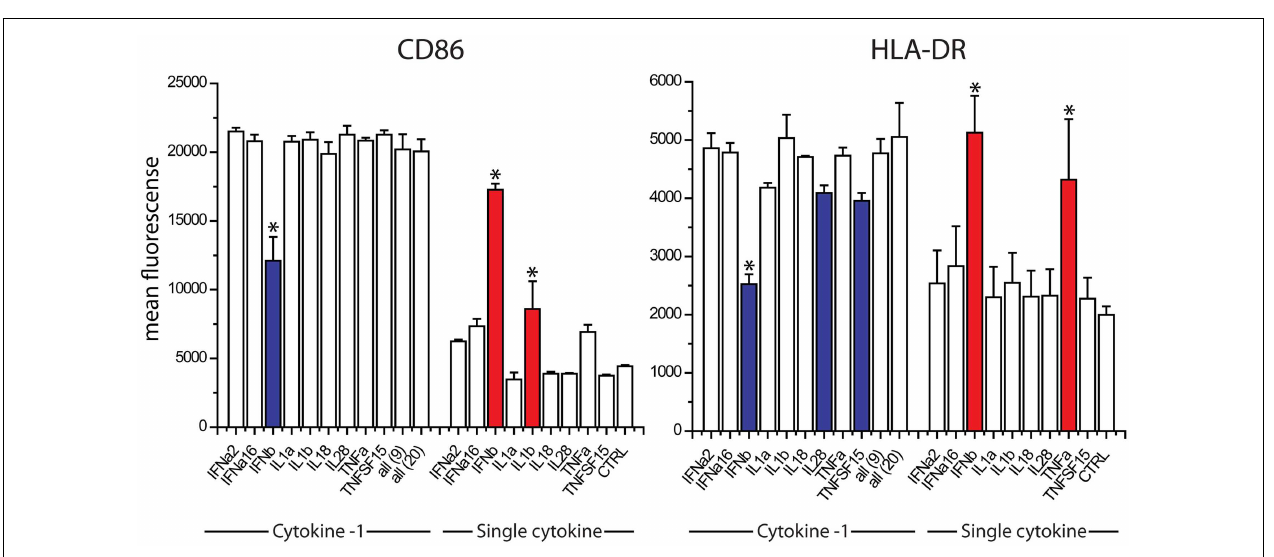
each individual cytokine treatment (Single cytokine) (* p ≤ 0.002 to cells exposed to all nine cytokines in Cytokine-1 treatment and to untreated cells in the single cytokine